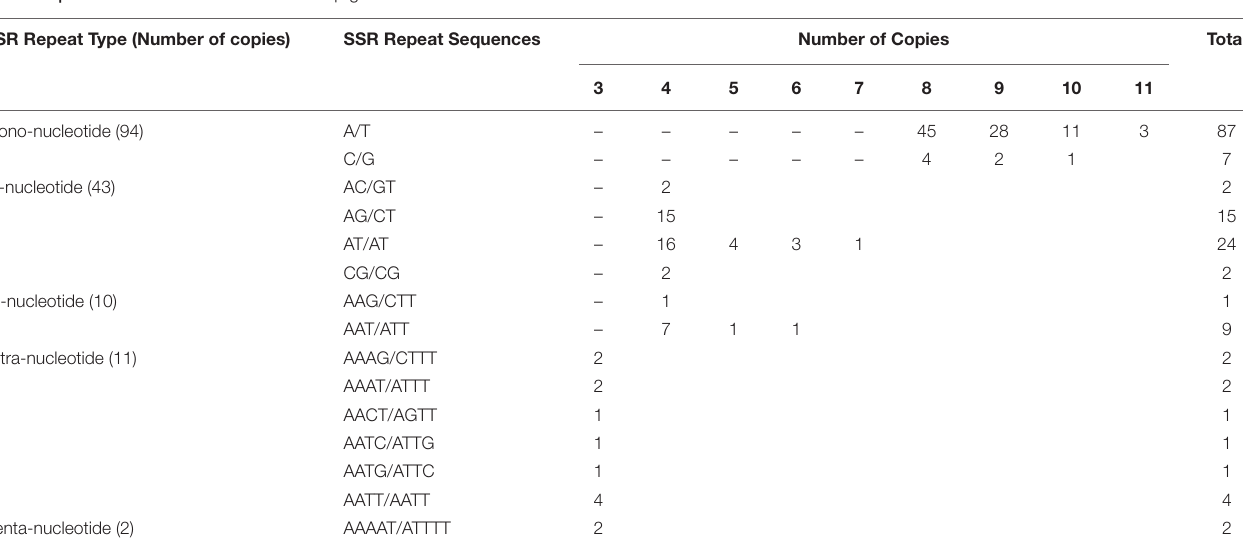
TABLE 2 | Numbers of SSRs identified in the cp genome of S.